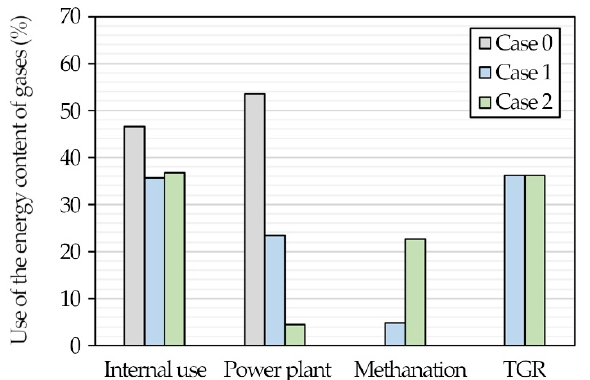
Figure 5. Use of the energy content of the total gases (COG, BFG, and BOFG) by type of process for each plant layout (i.e., Case 0–2).